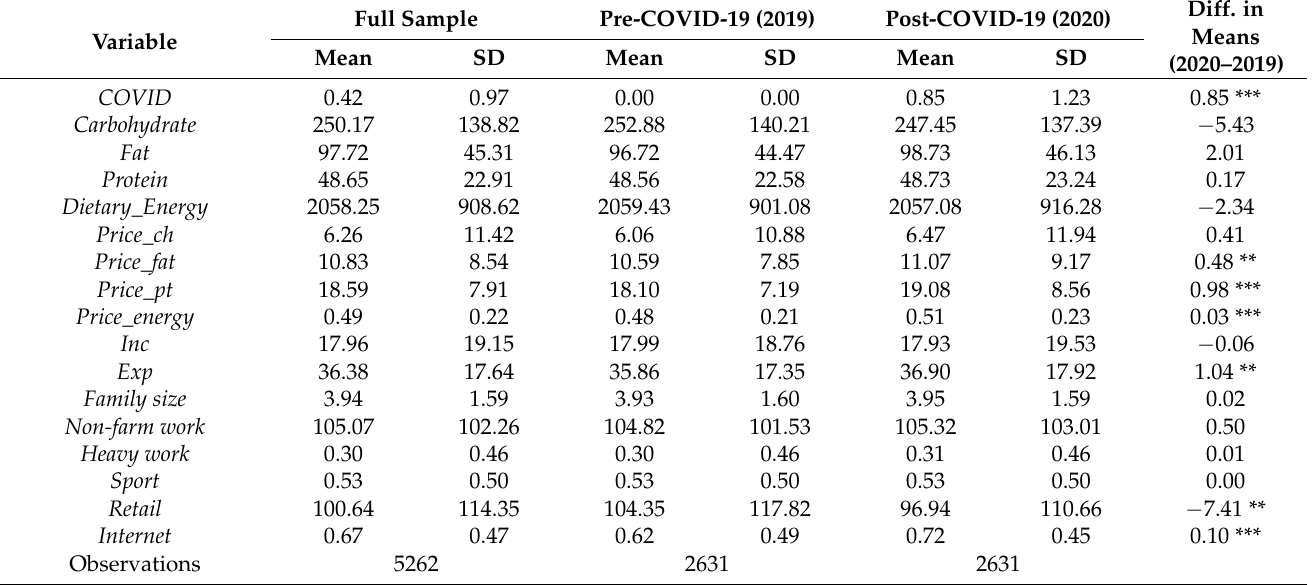
Table 2. Summary statistics for major